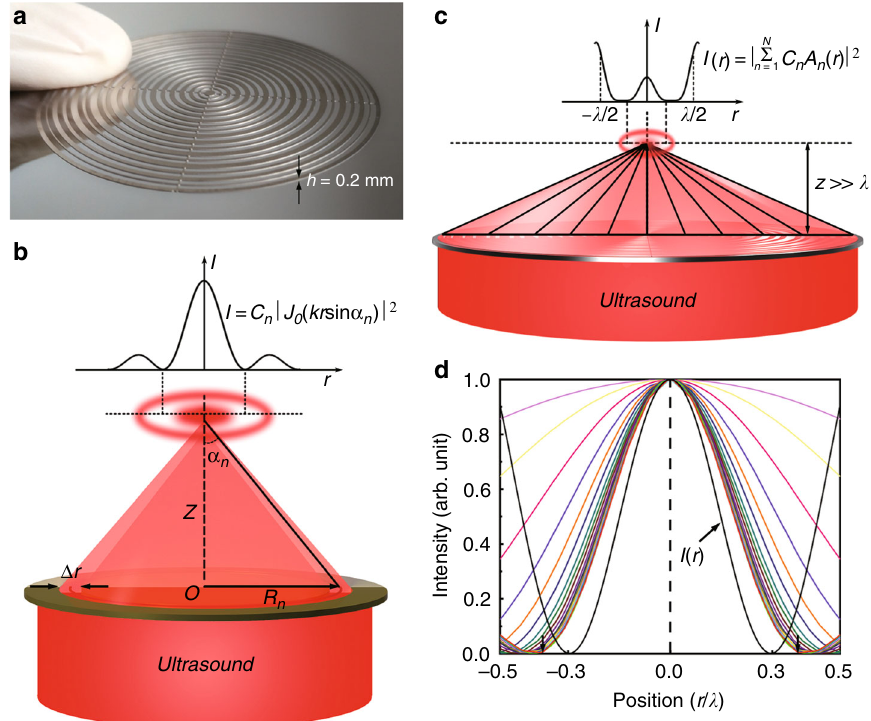
Fig. 2 Super-oscillation ultrasonic meta-lens. a A photograph of the ultrasonic meta-lens. The thickness of this meta-lens is only 0.2 mm, that is, (cid:1) 0 : 13 π at the operation frequency of 1 MHz. b The ultrasound diffraction from a single-belt Fresnel zone plate with the radius and width marked by R n and Δ r . The 2 , where the size of the principal lobe is determined by the diffraction limit (0 : 38 λ ). c Ultrasound fi eld intensity in the focal plane I ¼ C J kr sin α n j n Þj 0 ð diffraction from a multiple-belt meta-lens. A radially super-oscillating fi eld pattern is generated beyond the evanescent region ( z >> λ ). d Normalized intensity distributions in the focal plane. The pseudo-colored curves correspond to different spatial frequency components. The black curve is the super- oscillation packet that beats the in-plane diffraction limit, which is generated by superimposing those components. The bottom arrows in d indicate the location of the diffraction limit (0 : 38 λ )